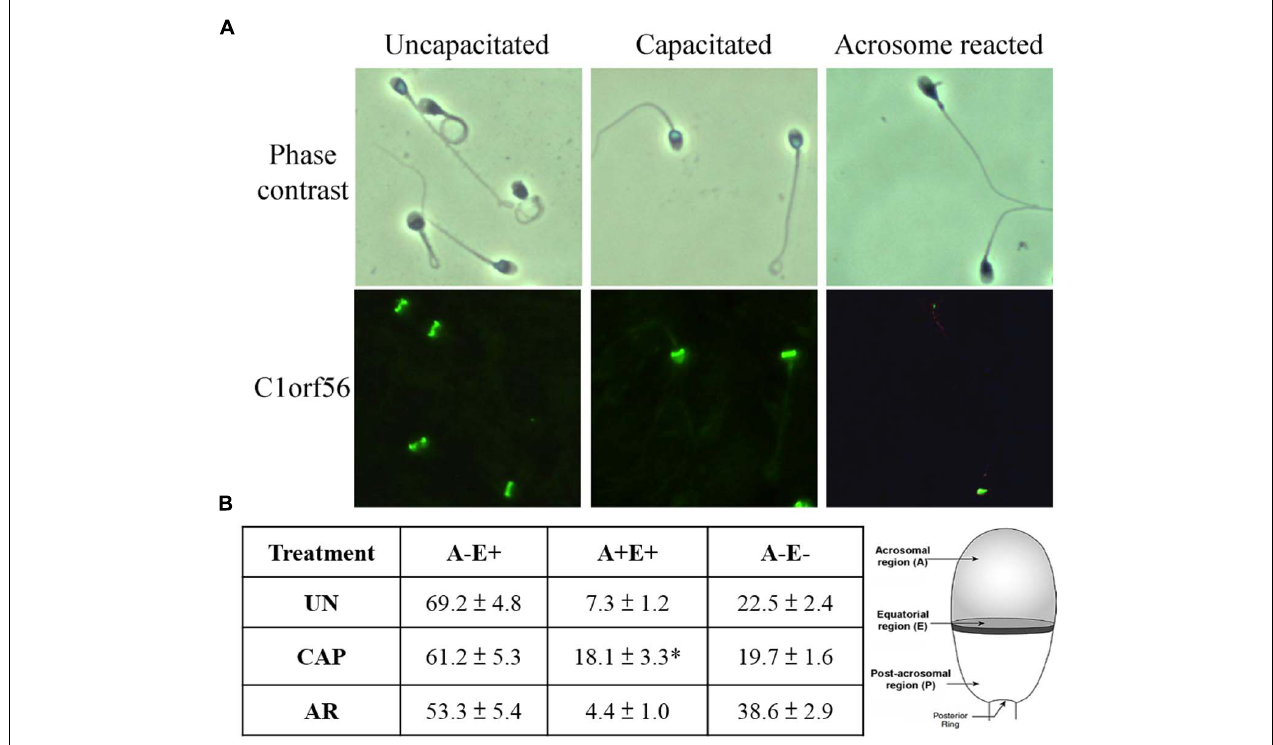
FIGURE 3 | Acrosomal region of human spermatozoa possesses strong C1orf56 immunoreactivity after capacitation. (A) C1orf56 immunoreactivities were visualized using Alexa Fluor 488-conjugated secondary antibody. Three staining patterns were observed in the C1orf56-positive sperm: (A–E+): Focal signals over the equatorial region; (A+E+): Strong signals over both the equatorial and acrosomal regions; (A–E–): No staining signal on sperm head. All the results shown are representative of five replicate experiments. (B) Percentage of C1orf56-positive sperm with A–E+, A+E+, or A–E– staining patterns. 200 C1orf56-positive sperm in randomly selected fields were determined under a fluorescence microscope after immunostaining. All data are represented as mean ± standard error of the mean (SEM). * P < 0.05 when compared the percentages of A+E+ staining pattern of C1orf56 in capacitated (CAP) sperm with uncapacitated (UN) or acrosome reacted (AR) sperm. A, acrosomal region; E, equatorial region, N = 10.